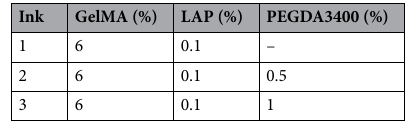
Table 1. Ink compositions for material